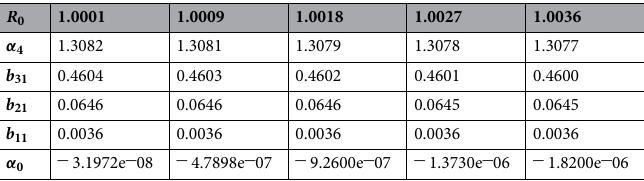
Table 5. Values of the first column of the Routh table when R 0 > 1